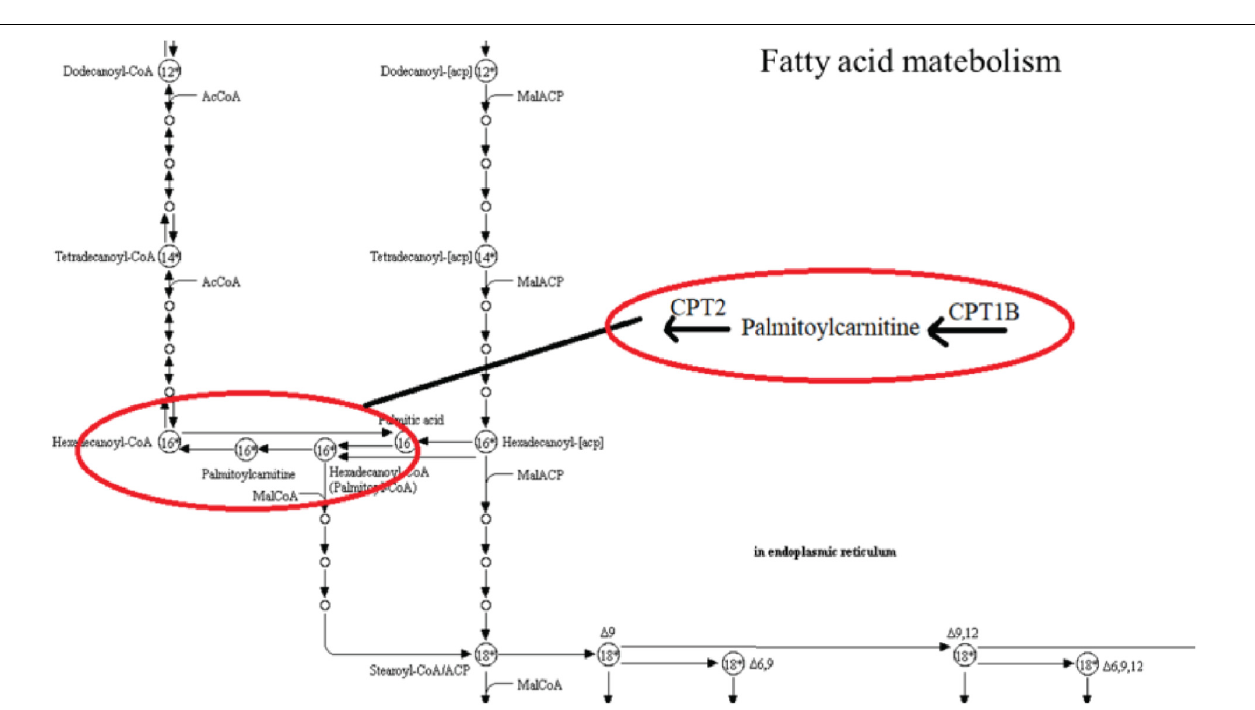
FIGURE 12 | Kyoto Encyclopedia of Genes and Genomes (KEGG) pathway from an original KEGG pathway. Fatty acid metabolism KEGG pathway shows the interactions of proteins and metabolites with red circles.